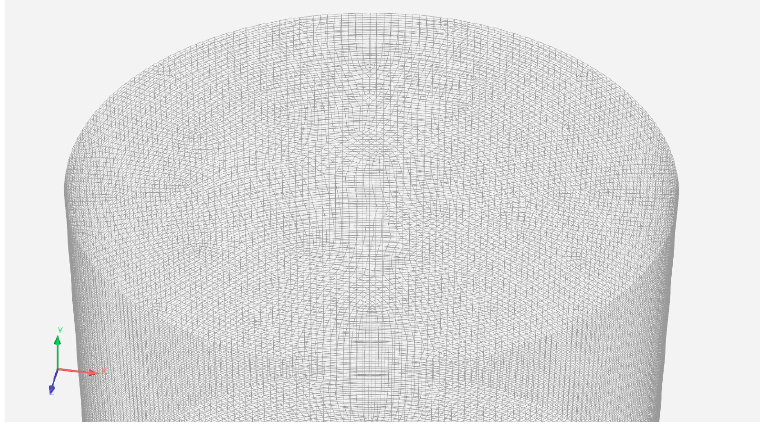
Figure 2. Image of the canister hexahedral mesh, featuring 1,925,440 cells (0.3 mm 3 /cell). Table 1. Compounds’ density and viscosity